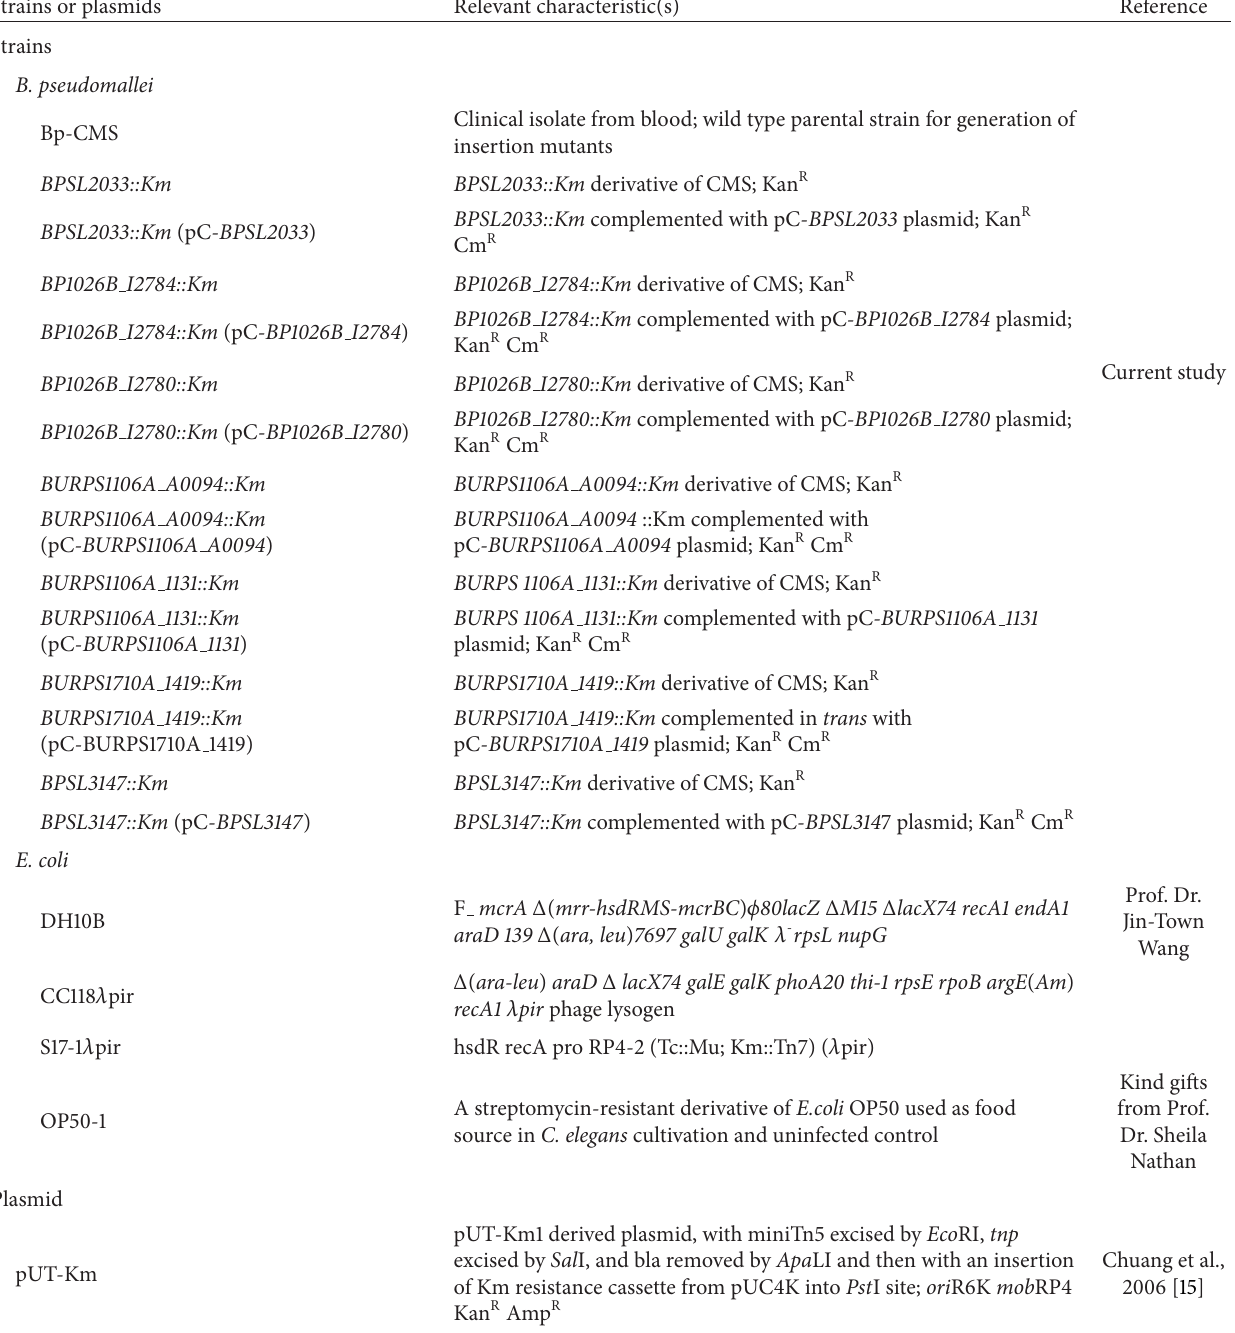
Table 1: Bacterial strains and plasmids